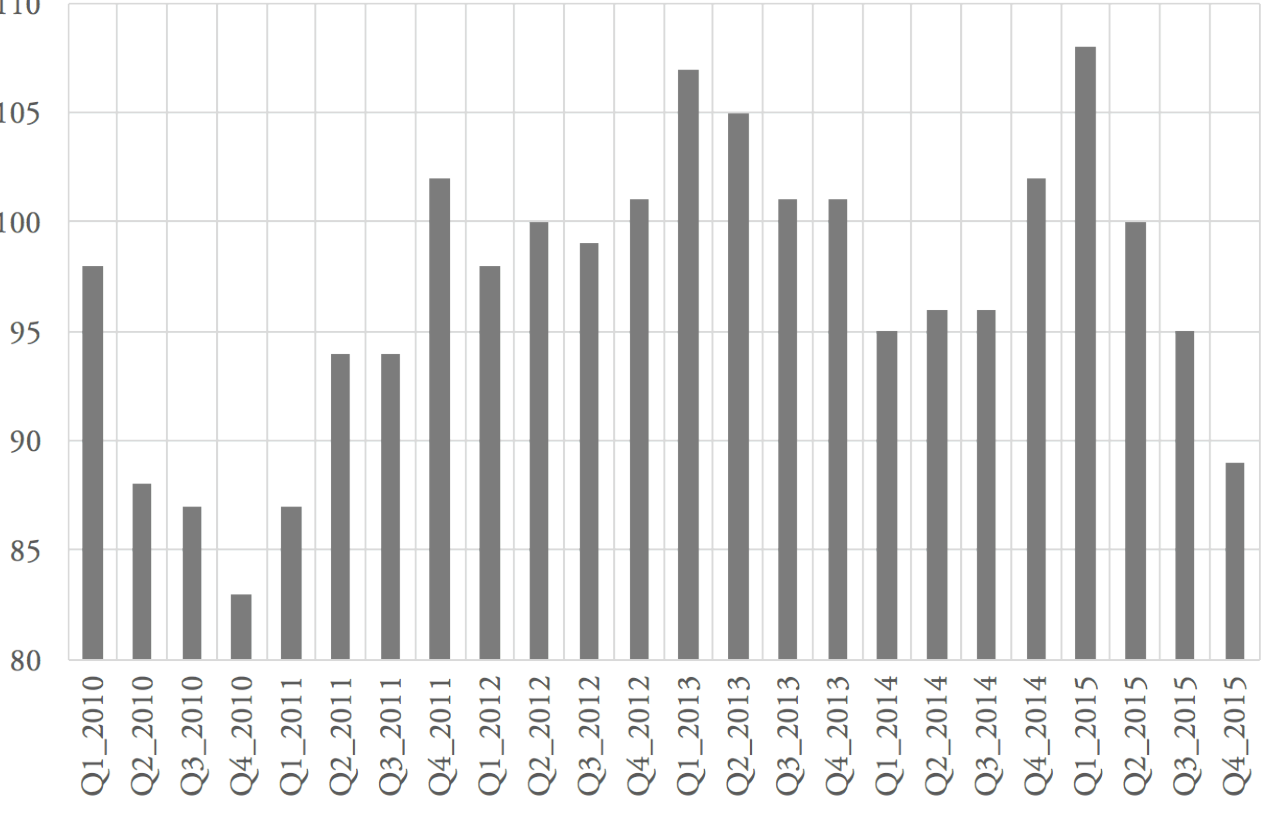
Figure 9: Ethnicity profile of the recipients of OAEHSGCO and